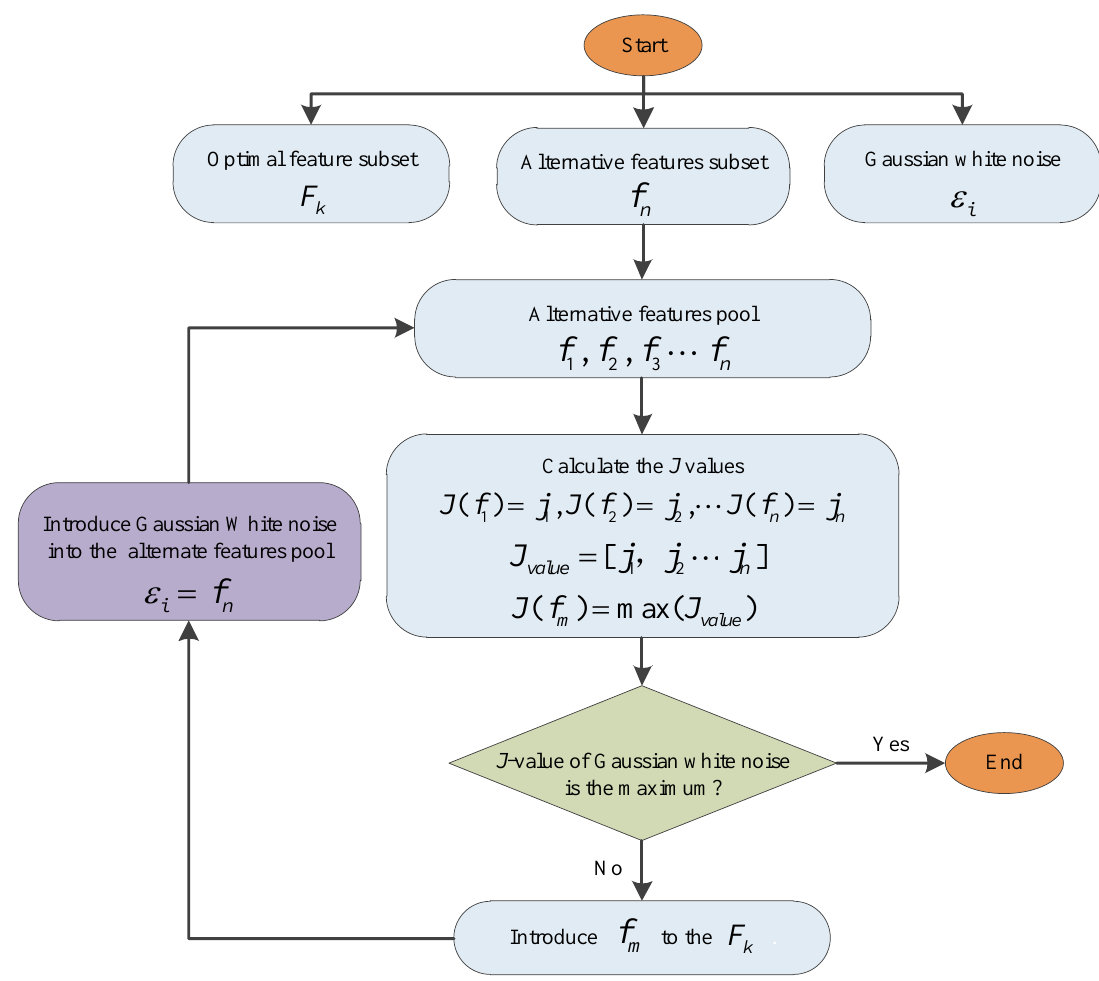
Figure 2. adaptive sequential optimal feature selection.